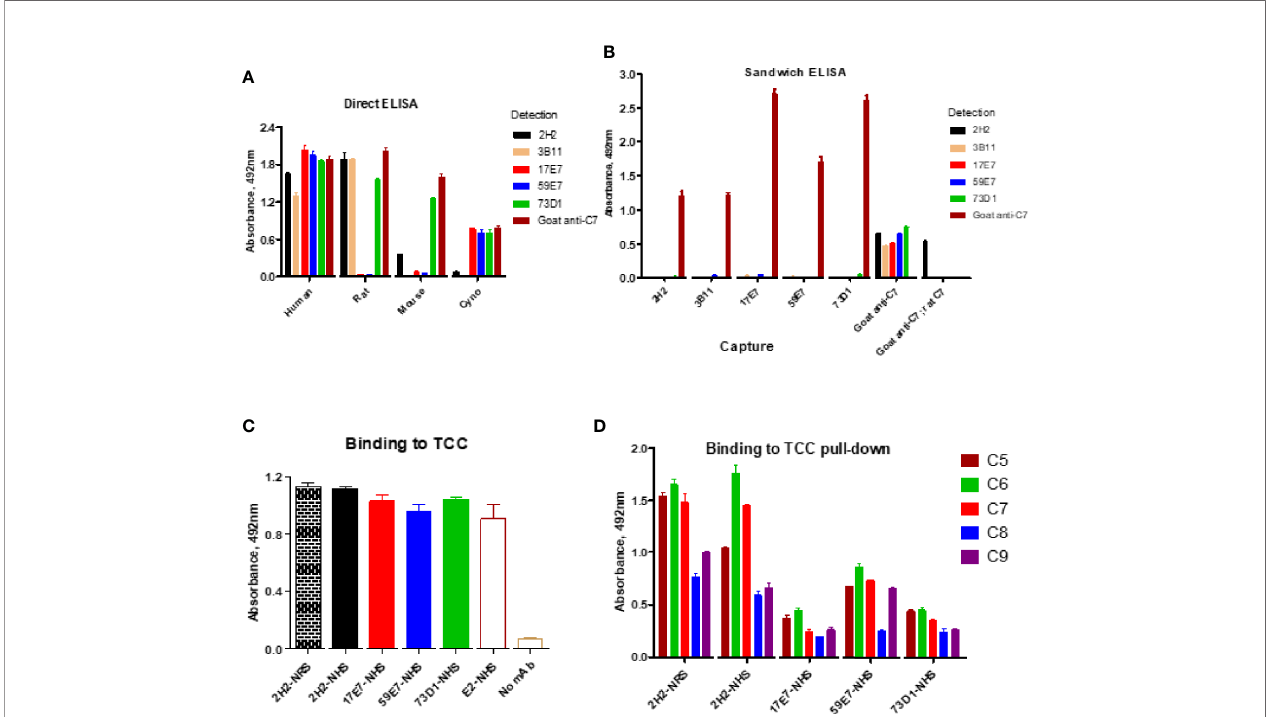
FIGURE 2 | Direct and sandwich ELISA to determine mAb binding to human, monkey, rat and mouse C7. (A) Direct ELISA: plates were coated with human, monkey (cyno), rat or mouse C7; mAbs were tested in a dilution series (0 – 10 µg/ml). The graph shows representative binding with the 10 µg/ml capture. (B) Sandwich ELISA: the new mAbs were paired as capture and detect with human C7 used in a dilution series (0 – 5 µg/ml). The graph shows representative binding with 5 µg/ml C7. As a positive control, polyclonal anti-C7 (goat anti-C7) was used as capture with each of the mAb as detect; rat C7 captured on goat anti-C7 (goat anti-C7; rat C7) was also tested with the mAb as detect. (C) Sandwich ELISA to detect pre-formed TCC in activated NHS; TCC in activated NHS (and NRS for 2H2) was captured on aE11 anti-C9 and the novel mAbs and the positive control E2 anti-C8 mAb used to detect the TCC complex captured. (D) TCC complexes generated in NHS (or NRS for 2H2) in the presence of each of the new mAb (biotinylated) were captured on avidin-coated plates, then polyclonal antibodies against each of the terminal complement proteins used to test the presence of the respective components in the complex. The error bars are standard errors of triplicates. All experiments were repeated three times with the same